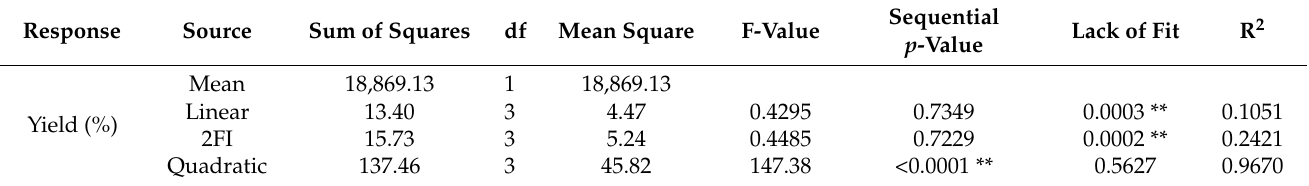
Table 3. Sequential model summary of yield.